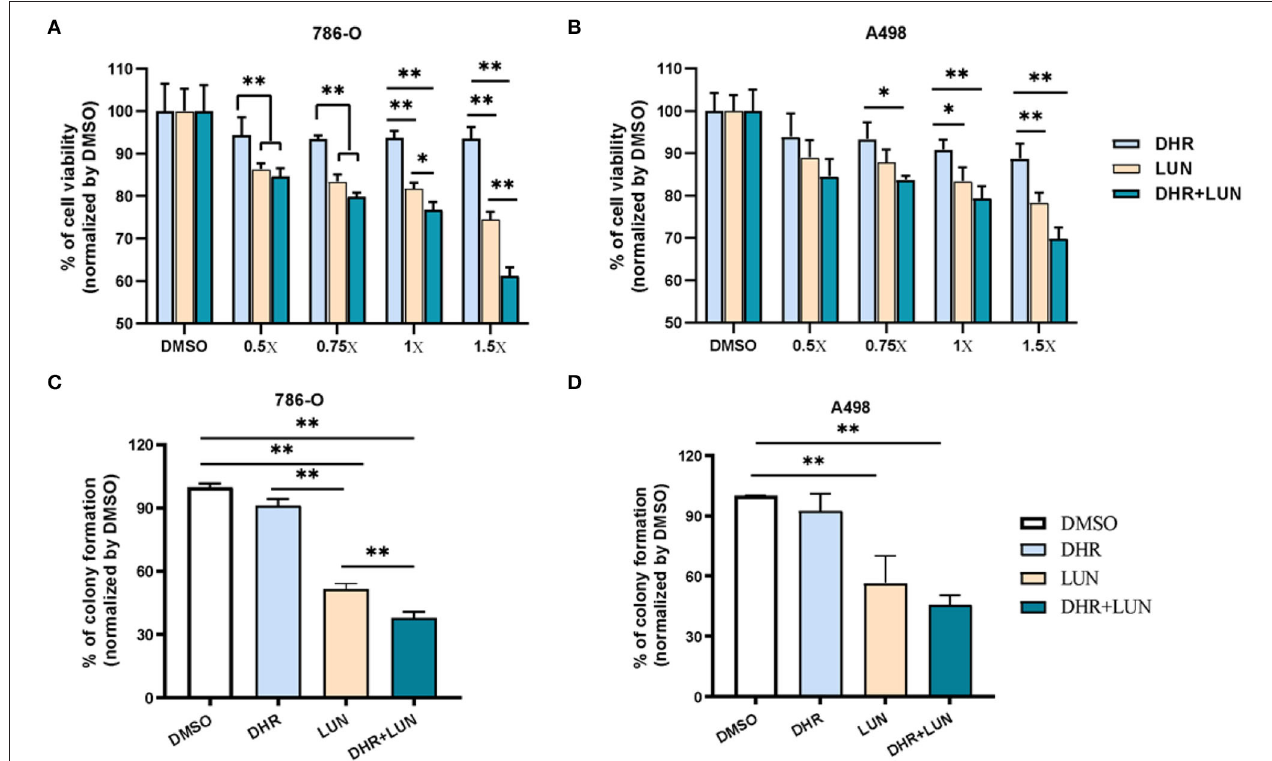
FIGURE 6 | Anti-proliferative and anti-clonogenic effects of DHR and LUN in renal carcinoma cell lines at tissue-relevant concentrations. Anti-proliferative effects of DHR and LUN in 786-O (A) and A498 (B) renal carcinoma cells. Anti-clonogenic effects of DHR and LUN in 786-O (C) and A498 (D) cells. Three independent experiments were conducted. Data presented as mean ± SEM. Significant differences are indicated: * P < 0.05, ** P < 0.01.